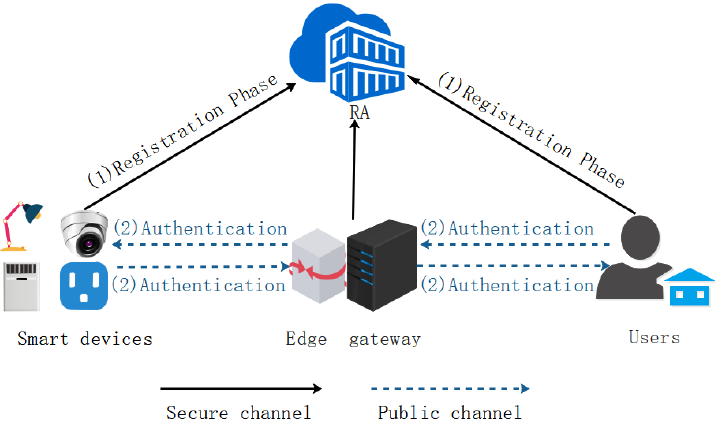
Figure 2. System model.